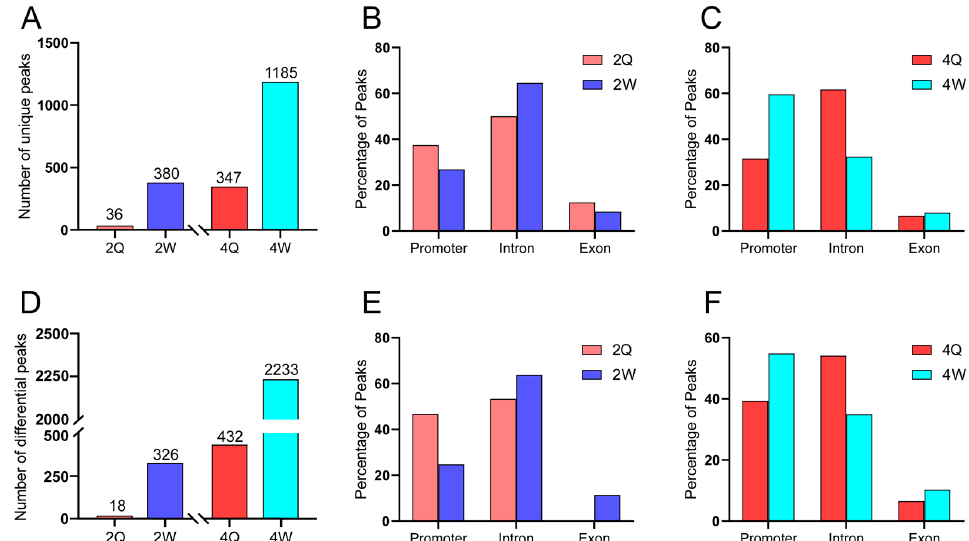
Figure 1. ( A ) Bar plot showing the number of unique H3K4me1 peaks in queen and worker larvae. ( B , C ) Bar plot showing the percentage of unique H3K4me1 ChIP-seq peaks within promoters, introns, and exons in 2Q vs. 2W and 4Q vs. 4W. ( D ) Bar plot showing the number of differential H3K4me1 peaks in queen and worker larvae. ( E , F ) Bar plot showing the percentage of differential H3K4me1 ChIP-seq peaks within promoters, introns, and exons in 2Q vs. 2W and 4Q vs. 4W.